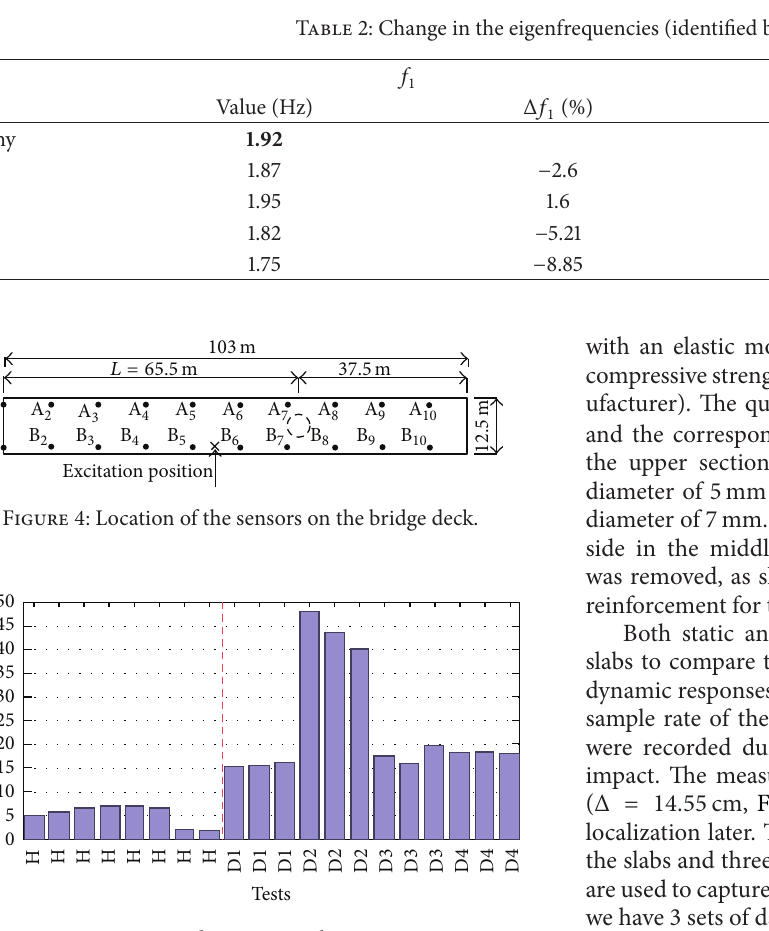
Figure 5: Damage detection results using